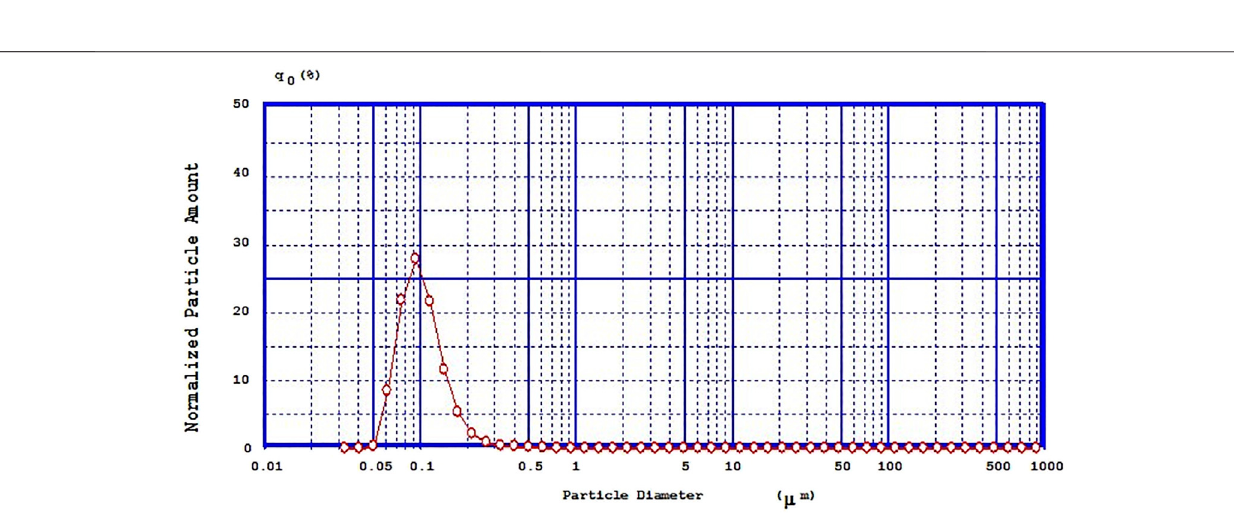
FIGURE 3 | Typical graph of particle size and size distribution of selected NE formulation